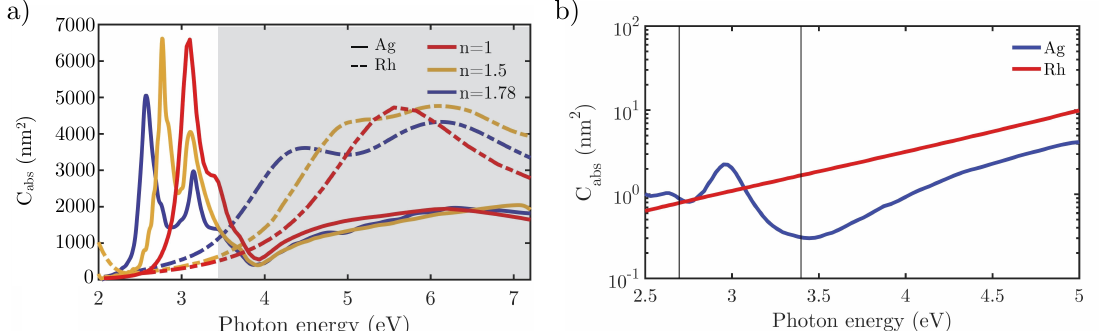
Figure 10. ( a ) absorption cross-section ( C abs ) of a L = 30 nm and R c = 2 nm Rh (dashed line) and Ag (solid line) NC under normal incidence with a P-polarization beam on substrates with different refractive indices. The shadowed region corresponds to the UV range; ( b ) absorption cross-section ( C abs ) for L = 5 nm Rh and Ag (with 1 nm Ag 2 O shell). The vertical lines indicate two commercial wavelengths ( 460 nm (2.7 eV) and 365 nm (3.4 eV),